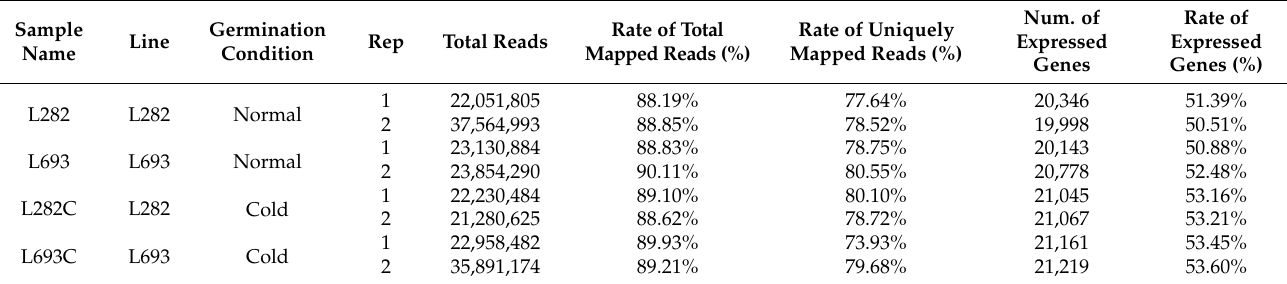
Table 1. Summary of transcriptome sequencing.